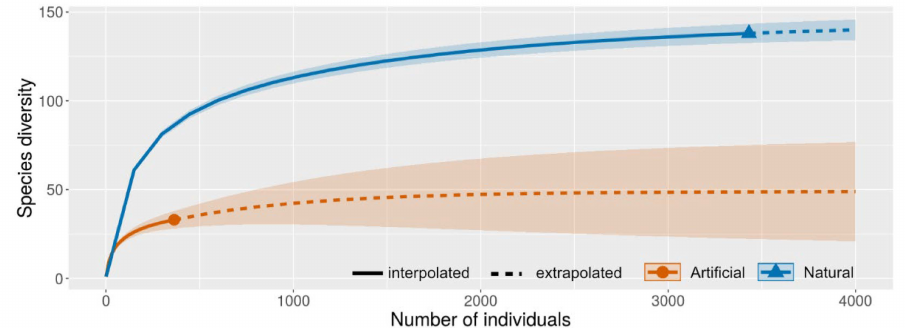
Figure 8. Diversity comparisons for mosquitoes in natural habitats and artificial containers. The shaded area represents 95% confidence intervals. Solid line = observed species (interpolation); dash line = extrapolation species richness. Sample coverage of the reference sample for each season: natural = 0.996, artificial = 0.986. q = 0, species richness with bootstrap of